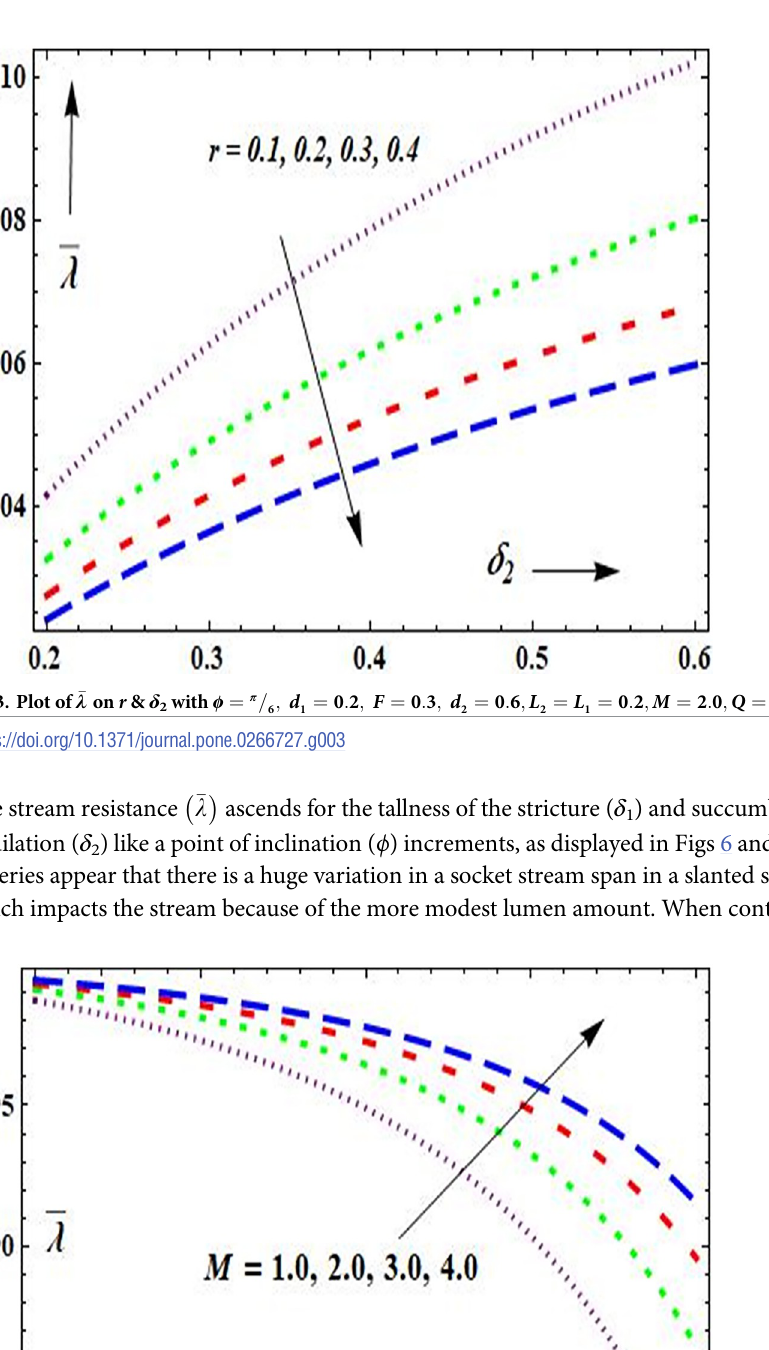
; d ¼ 0 : 2 ; F ¼ 0 : 3 ; d 6 1